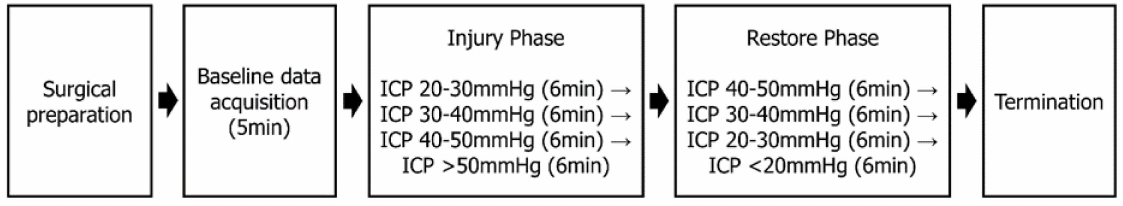
Figure 1. Experimental